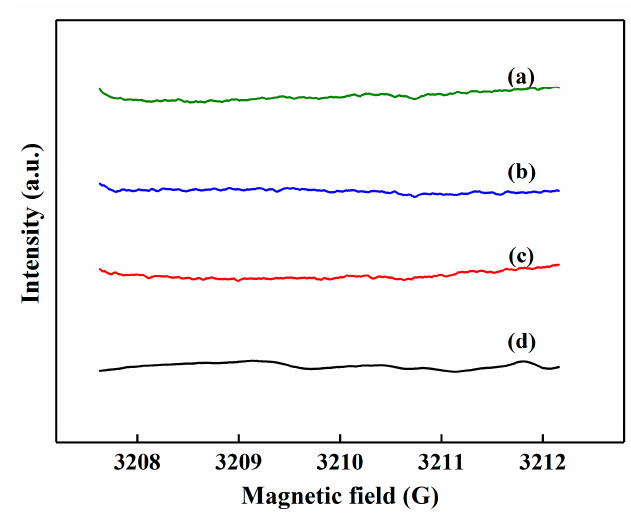
Figure 8. In situ electron spin resonance (ESR) spectra of photocatalytic ORR over different photocatalysts under visible light irradiation. Photocatalysts: ( a ) CN, ( b ) β -CD-CN, ( c ) 0.05%Au / β -CD-CN, ( d ) 0.05%Pt / β -CD-CN.